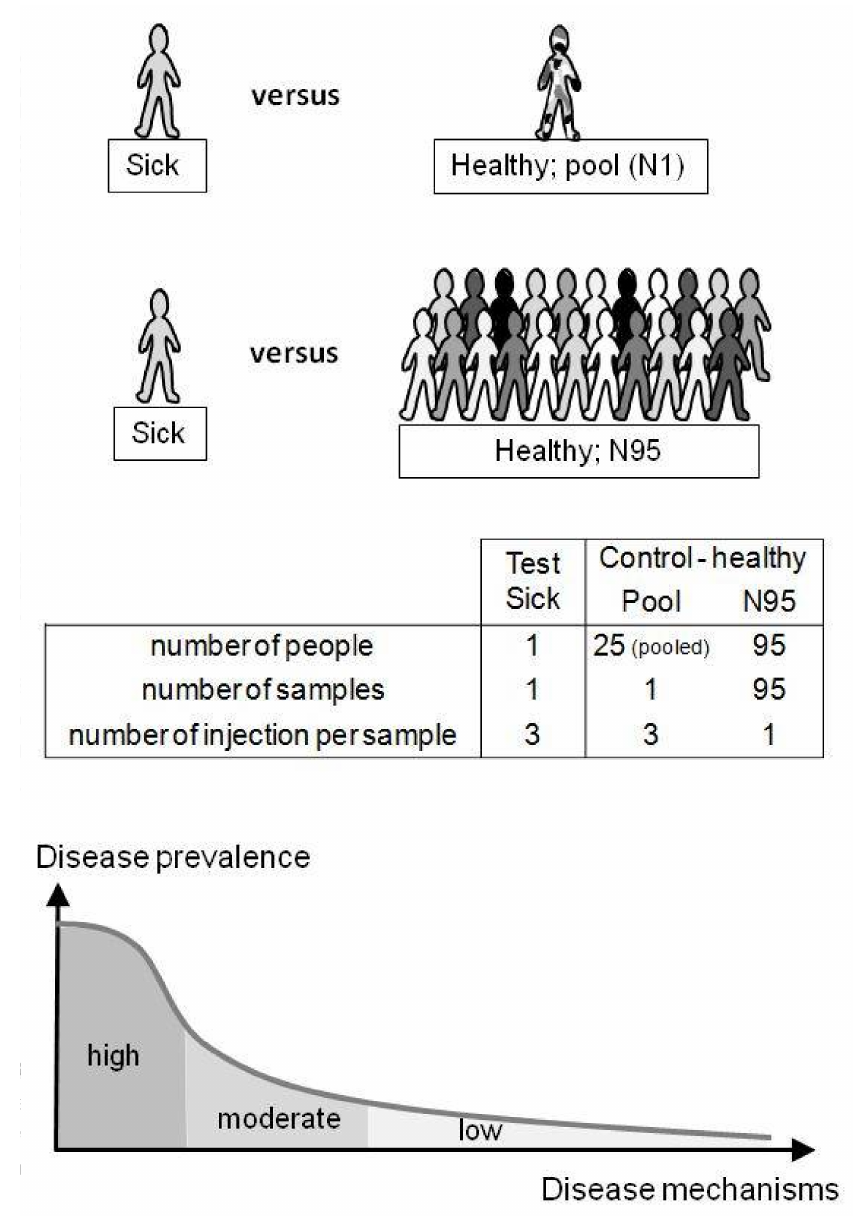
Figure 2. Untargeted diagnostic screening (UDS) compares one person’s metabolome (test) with healthy metabolomes (control). In this study, the control group was a pooled sample ( N = 1) of identical serum volumes from 25 different healthy donors (Pool) or 95 different serum samples from healthy donors ( N = 95). The uniqueness of the patient’s metabolome is taken into account (N-of-1 study) and does not necessarily have to belong to a group of patients (“tyranny of the average”). UDS can be of interest when considering misdiagnosis and the high number of low-prevalence diseases (“long-tail disease”;